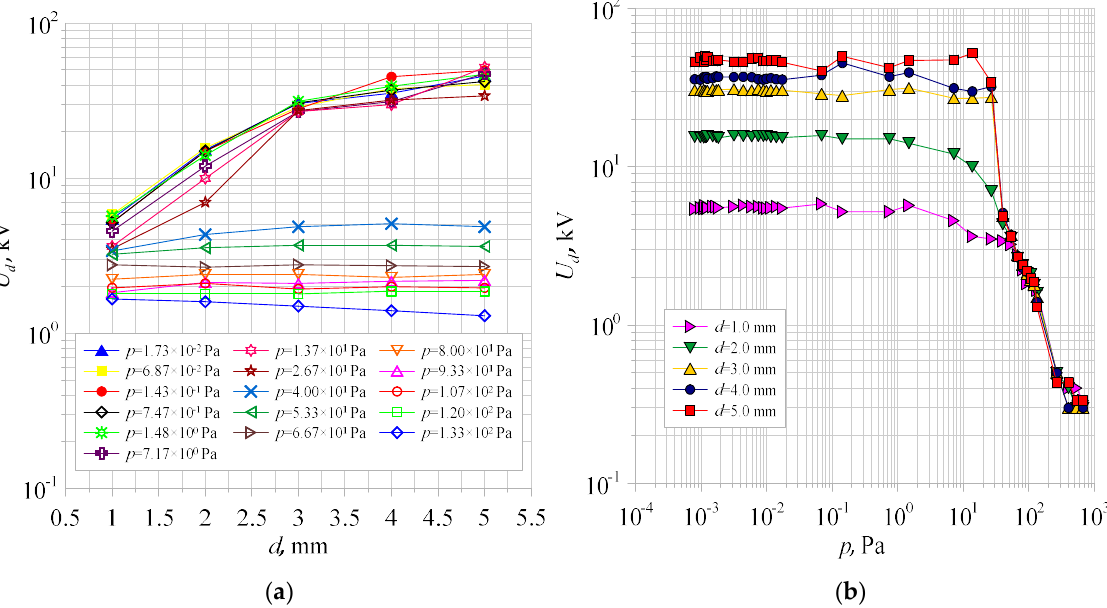
Figure 7. Dependences of breakdown voltages U d as a function of ( a ) electrode spacing d for selected pressure values and ( b ) pressure p inside the tested vacuum interrupter, for residual gases being helium.